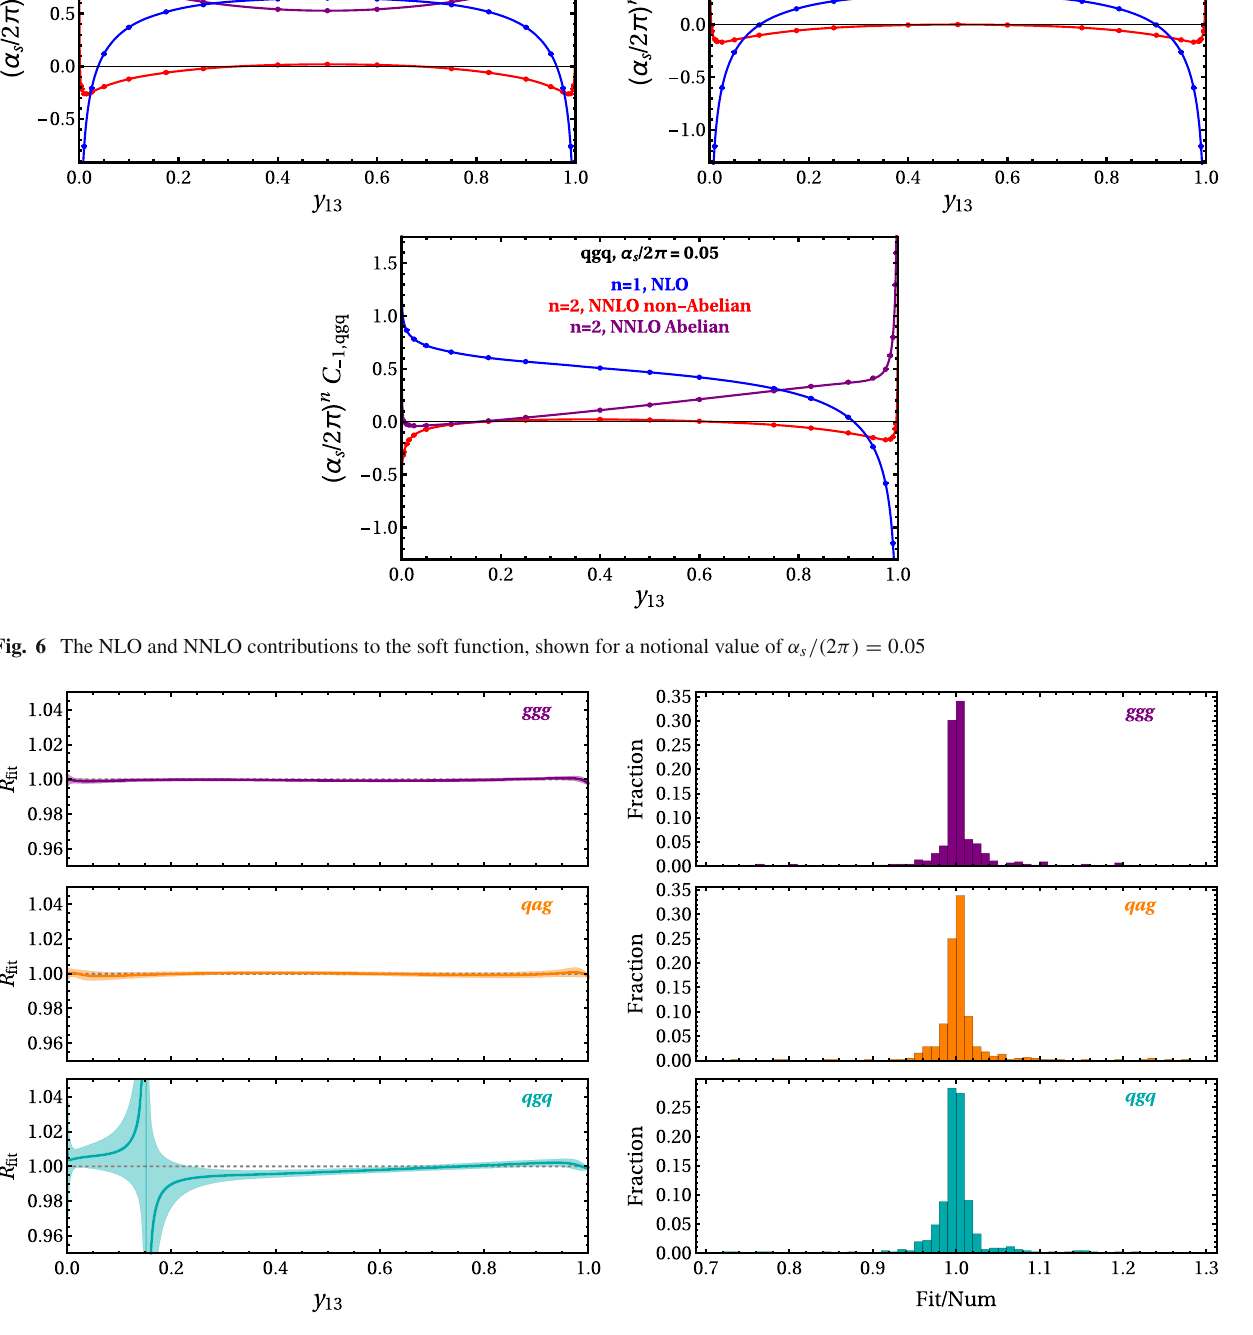
Fig. 7 Left panel: ratio between the LHC limit of the fits of Eq. (127) andthefitsofEq.(123)forthethreepartonicchannels.Theratio R fit has been defined in Eq. (128). Right panel: ratio between predicted values